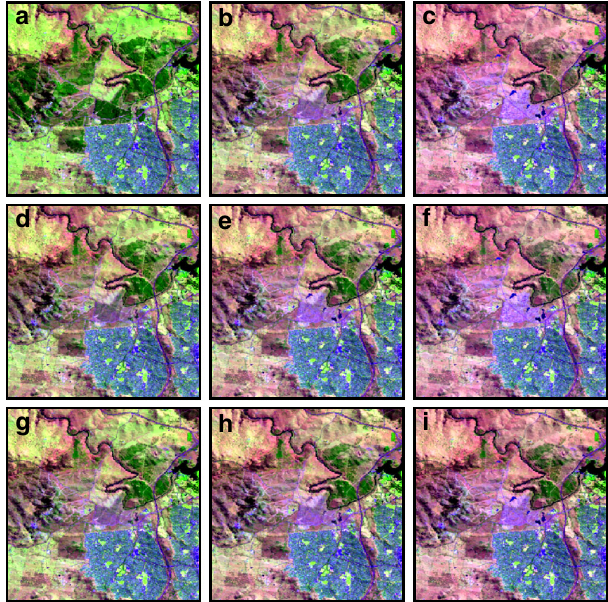
Fig. 9 Comparison of the effect of different weighting schemes on the output of the proposed algorithm. The effect of making choices of weight function ~ w shown across an area to the west of Canberra, Australia. The location was chosen due to the presence of urban, water, vegetation and soil classes. The images are shown in false colour with SWIR1, NIR and BLUE in the RGB channels to accentuate healthy vegetation in bright green, soils in magenta and water in blue/black. The histogram stretches for all images are the same and chosen based on a 2 – 98% cutoff of the histogram of b which is an unweighted GM pixel composite mosaic. The weighting schemes are as follows: a is NDVI, c is − 1 × NDVI, d is GNDVI, e is − 1 × GNDVI, f is − 3 × GNDVI, g is SAVI, h is − 1 × SAVI and i is − 3 × SAVI. We observe that c , f and i show the presence of the most soil across the image, however, f and i preference the presence of water (over soil) in some locations. NDVI provides good symmetry with respect to the GM case in b , in that a provides a highly vegetated composite and c a composite dominated by